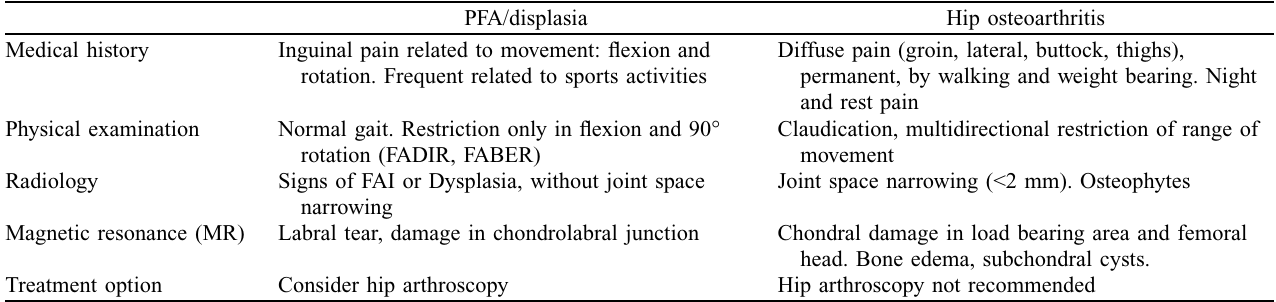
Table 2. Clinical history, physical examination, and imaging studies (X-rays, MRI) in patients with osteoarthritis of the hip secondary to FAI or dysplasia. Preoperative evaluation of these parameters can help to quantify the degree of chondral injury or osteoarthritis in this group of patients. These clinical parameters of easy access facilitate the identification of patients in early stages, which can benefit by hip